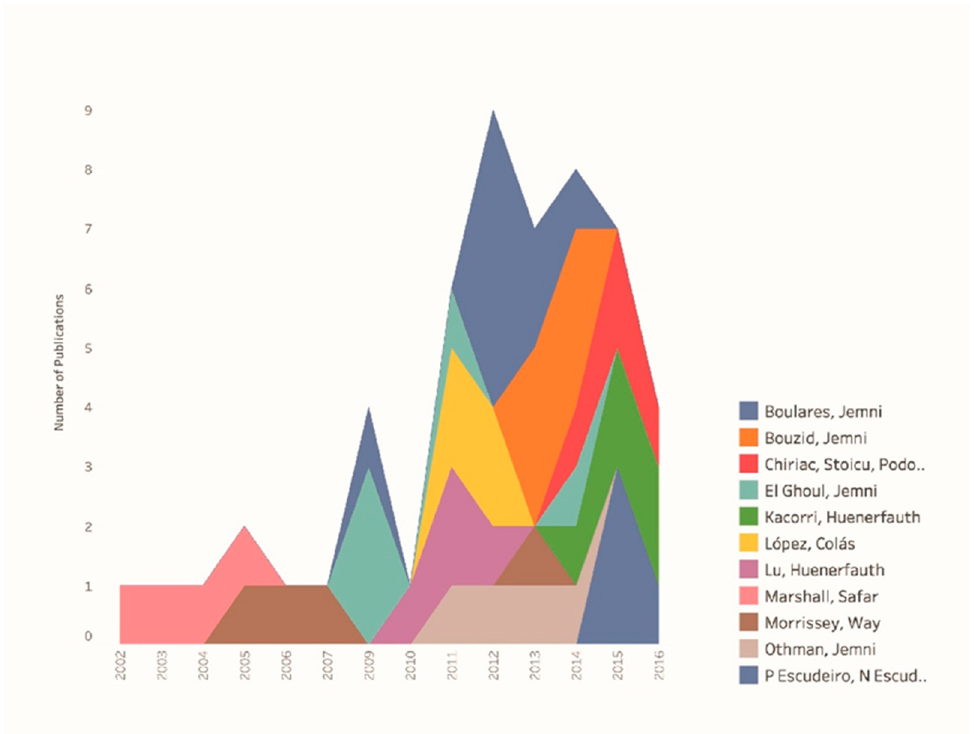
Figure 8. Research teams–years area chart.